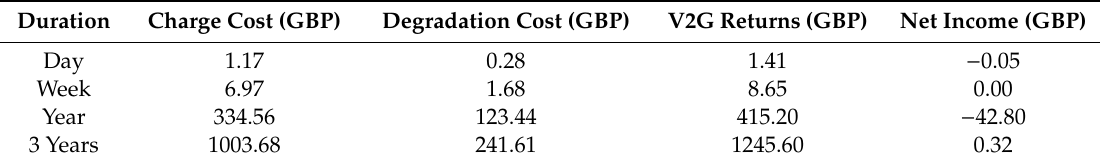
Table 4. Financial results of the V2G simulation across a working day, week, year, and three